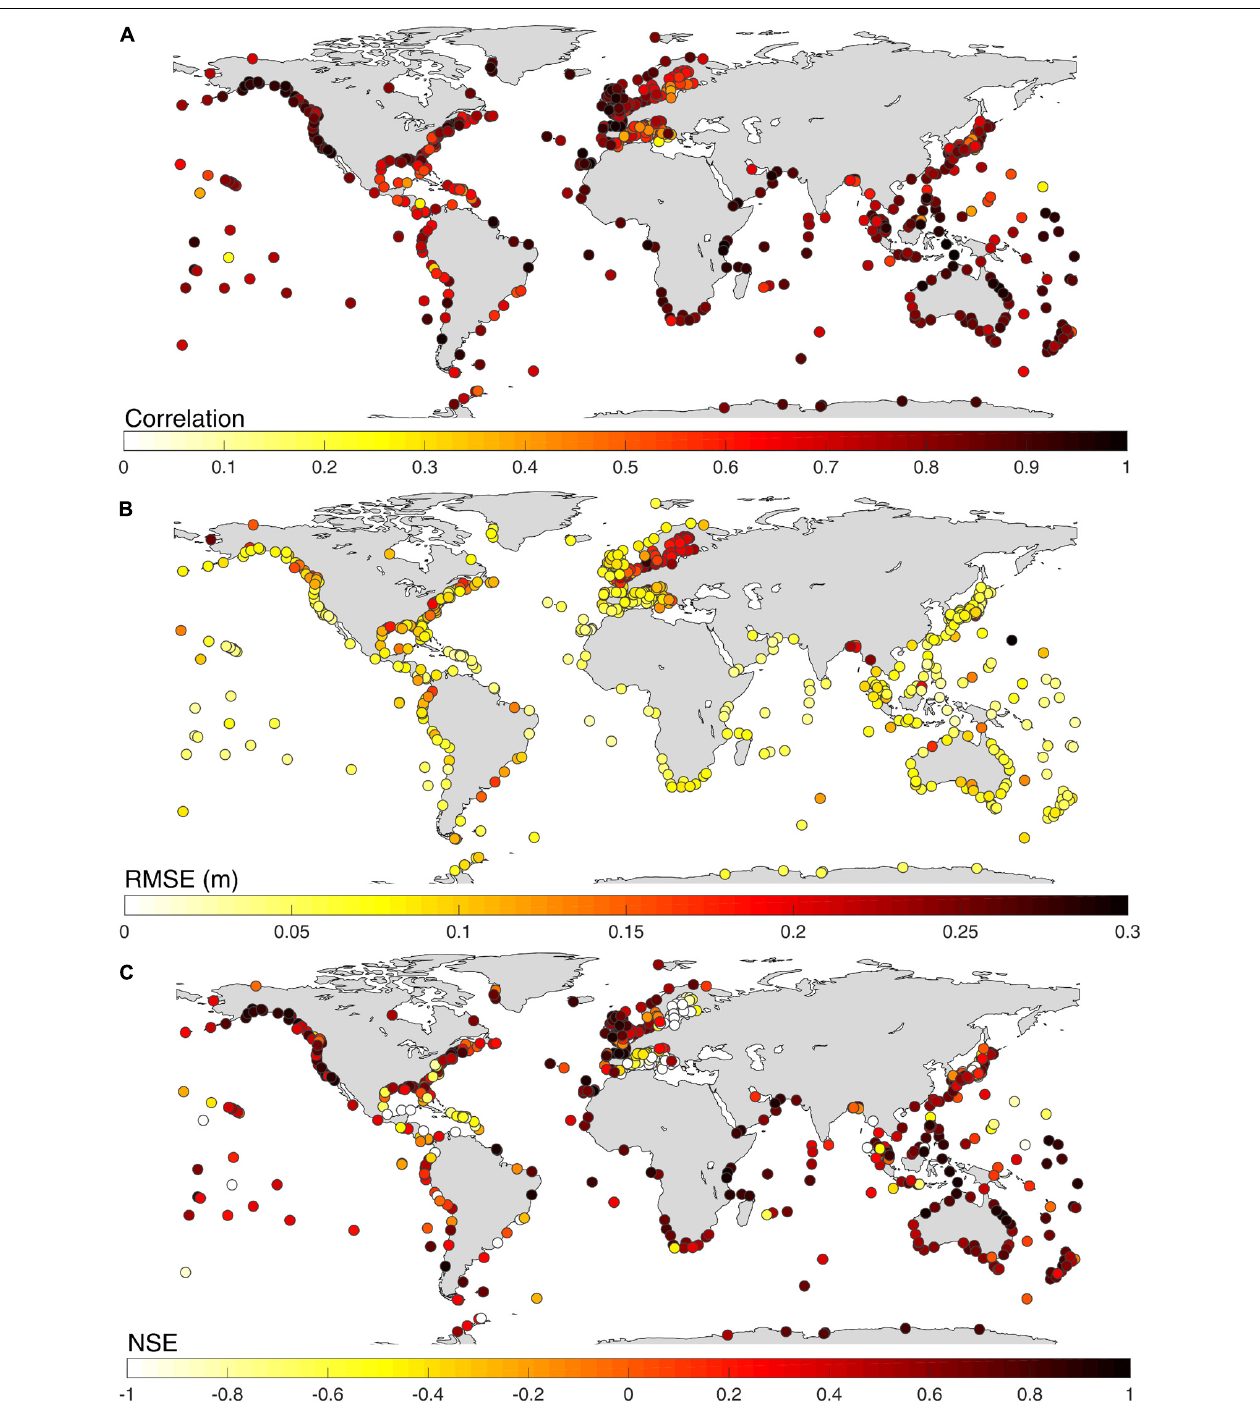
FIGURE 8 | Validation of Model-RS for total still water levels above the 95th percentile threshold: (A) Pearson’s correlation coefficient; (B) RMSE in m; and (C) NSE.